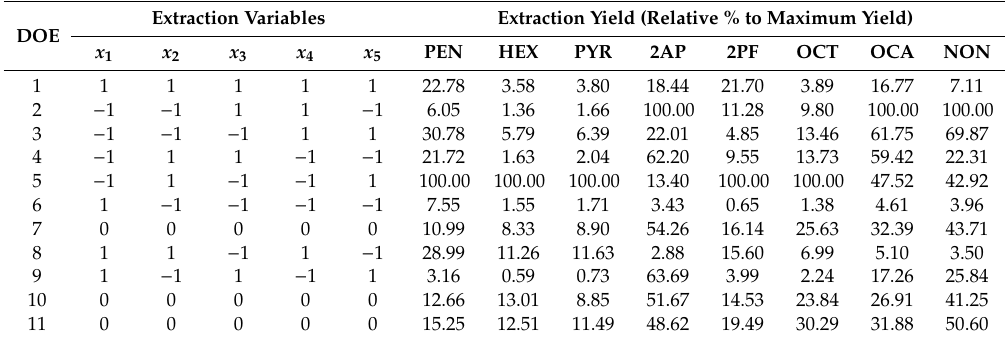
Table 3. The 2 5 − 2 fractional factorial design for five factors with their observed responses. III Extraction DOE